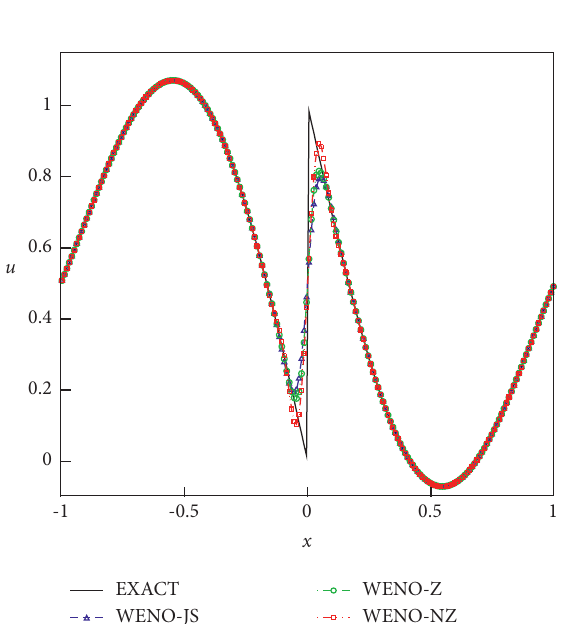
Figure 2: Numerical solution of Case 3 at t � 8 . 0 with grids of N � 200 (1D scalar convection equation with initial condition (61)) based on WENO-JS, WENO-Z, and WENO-NZ